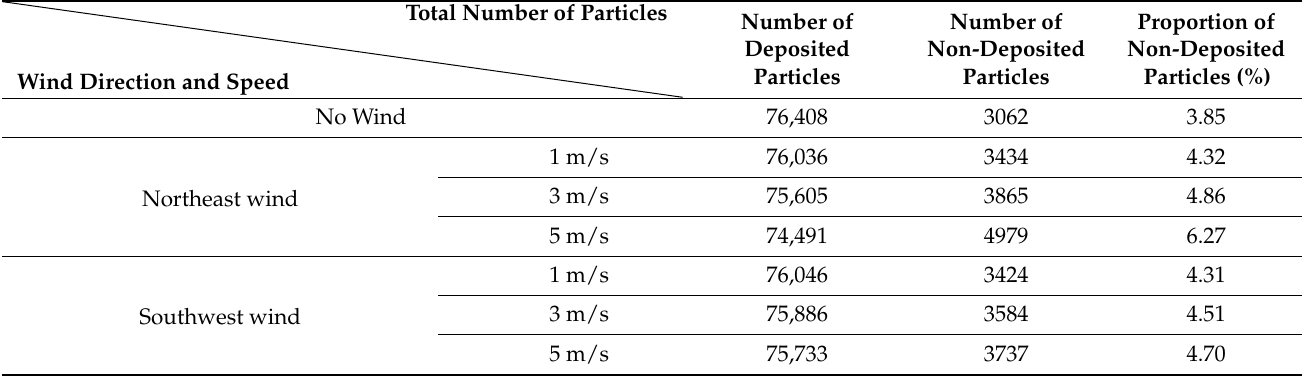
Table 6. Simulation result of dust deposition for 1 month with the wind at an inclination angle of 10°.